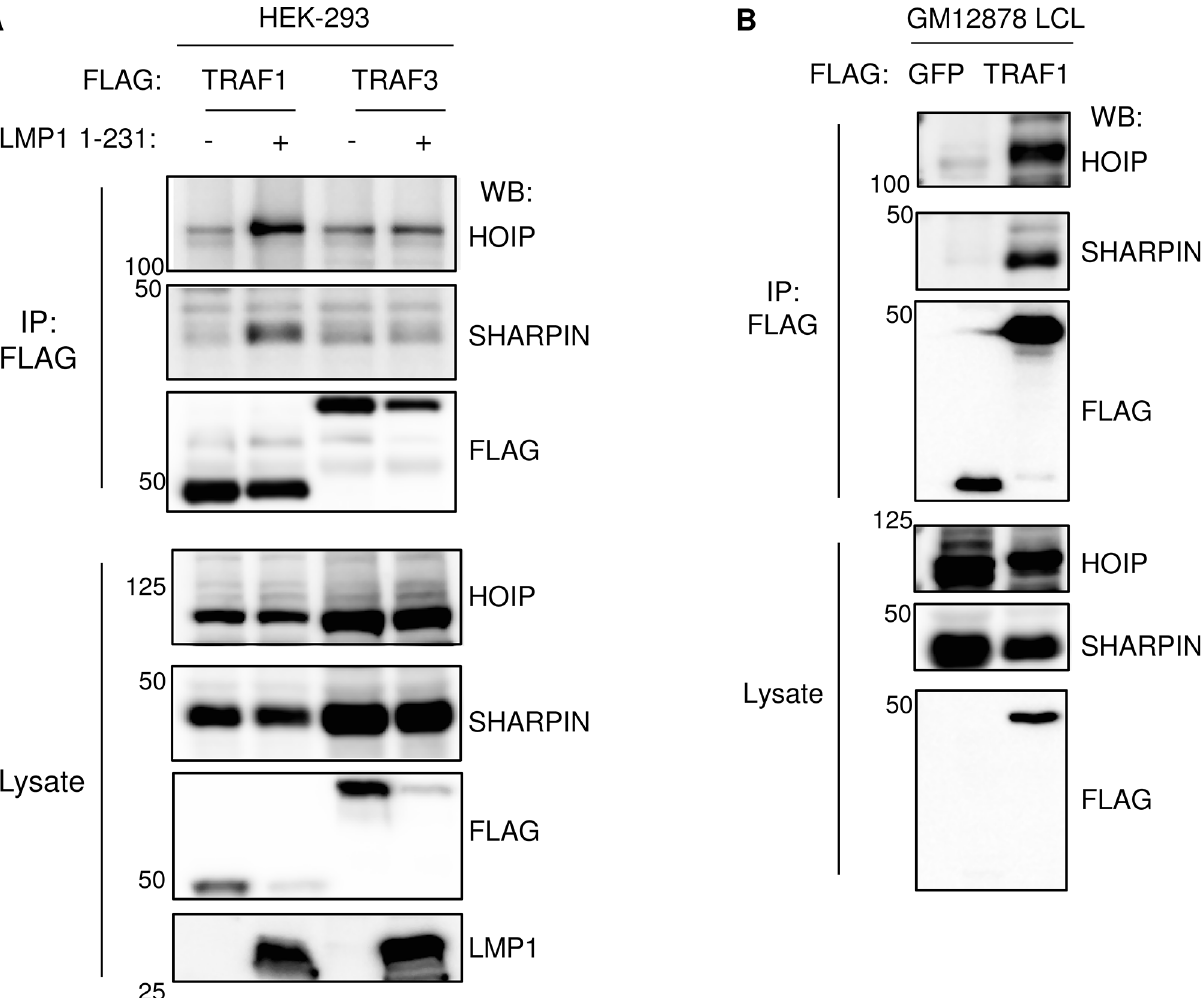
Fig 2. TRAF1 and LUBAC associate in LMP1-stimulated cells. A) 293 cells were transfected with FLAG-tagged TRAF1 or TRAF3, and LMP1 1 – 231 expression was induced 24 hours, as indicated. FLAG immuno-purified complexes and lysates were analyzed by western blot (WB), as indicated. B)